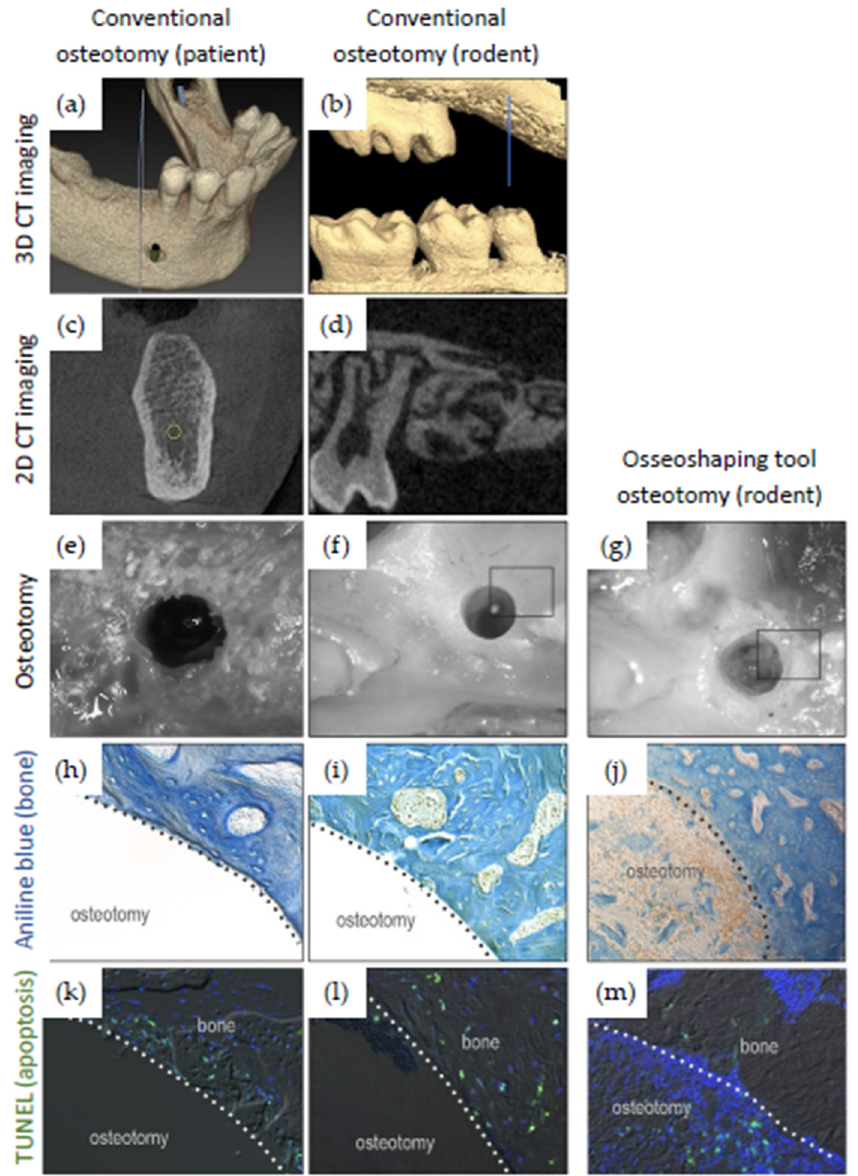
Figure 8. Comparison of osteotomies created following a conventional site preparation protocol ( left and middle columns ) and using the osseoshaping tool ( right column ). ( a – d ) Pre-operative patient CBCT ( a , c ) and rodent µCT ( b , d ) demonstrating the similar bone quality of the implant recipient site in human versus rodent. ( e – g ) Osteotomies created with conventional drills ( e , f ) and the osseoshaping tool ( g ). Note the irregular walls around the latter osteotomy ( g ). ( h – m ) Osteotomy sections stained for aniline blue to reveal bone and with TUNEL to reveal cell death (apoptosis) from sites prepared conventionally or with the osseoshaping tool. Application of the osseoshaping tool results in the visible presence of the osseous coagulum ( j ) and decreased levels of apoptosis ( m ). Dotted lines show the edge of the osteotomy .